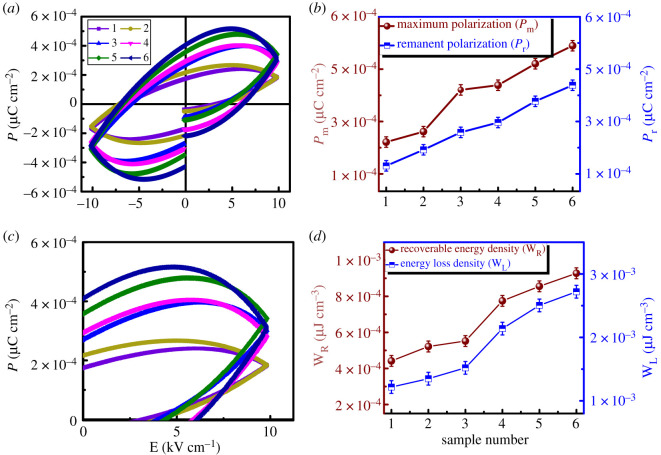
(a) P-E hysteresis loops, (b) Pm and Pr variation, (c) mono-polar P-E loops and (d) WR and WL plots of the (1) pure BFO, (2) x = 0.00, (3) x = 0.03, (4) x = 0.05, (5) x = 0.07 and (6) x = 0.1 in BiFe0.9Co0.1−xNixO3.